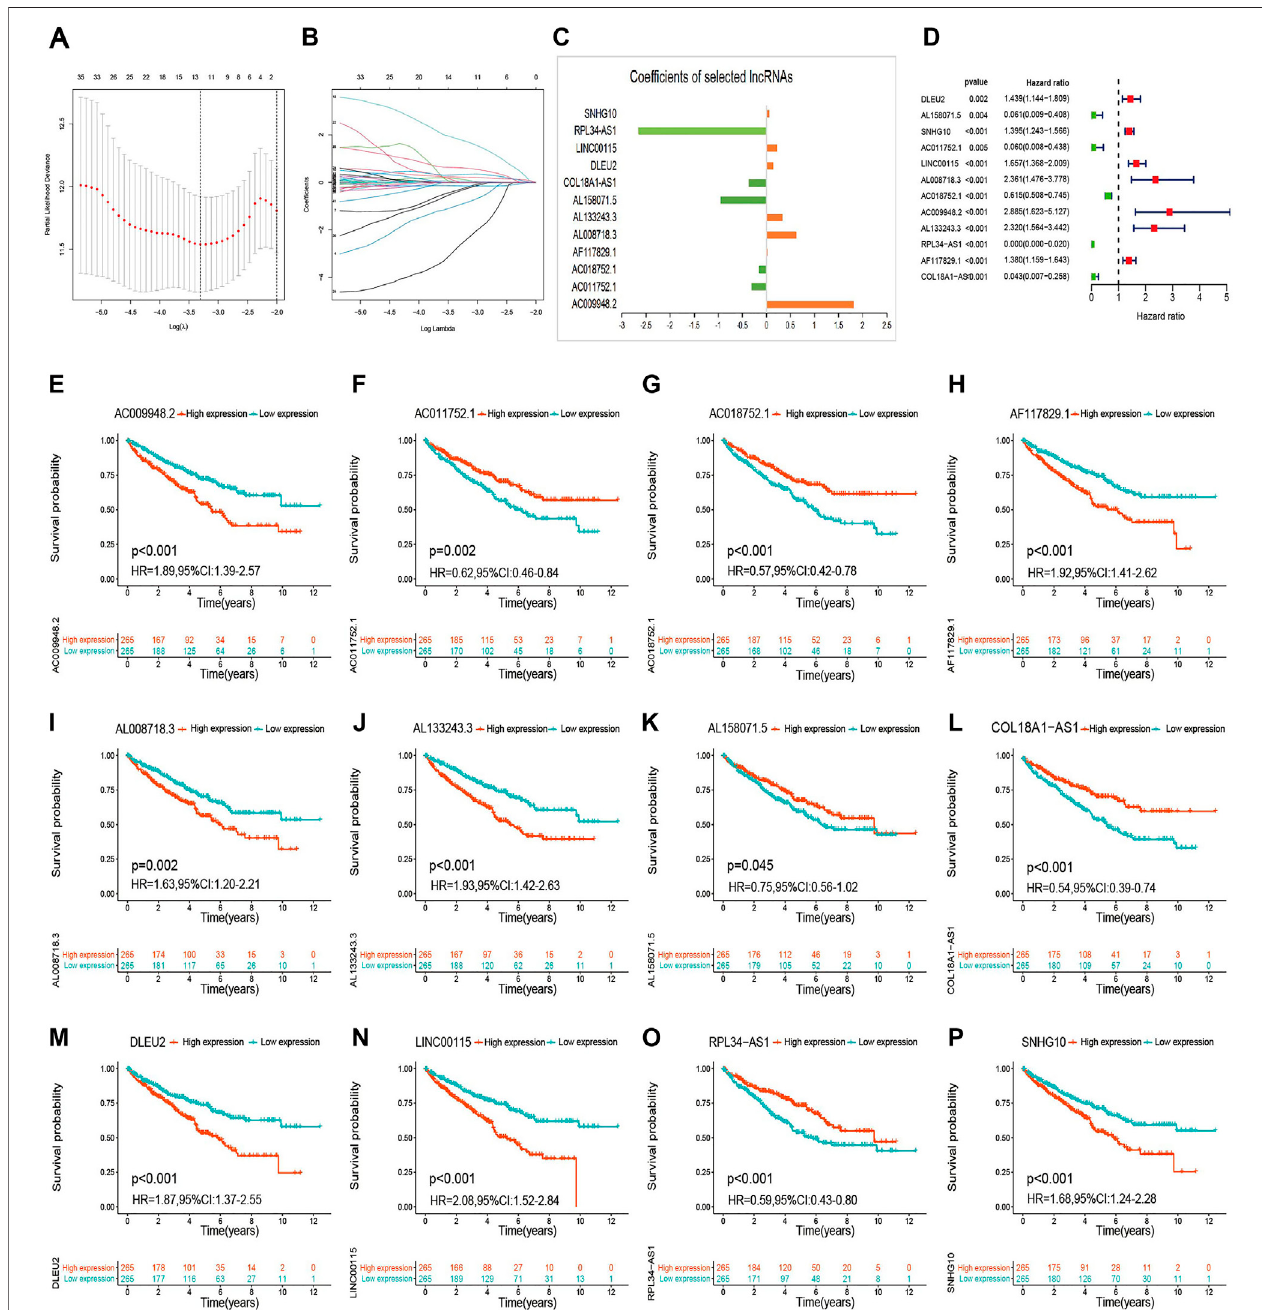
FIGURE5| Establishmentofthem6A-RLPS. (A – C) LASSOCoxregressionanalysistodeterminethe12m6A-RLsandtheircorrespondingcoef fi cients. (D) Forest plot of the 12 m6A-RLs. (E – P) Kaplan – Meier curves indicating different overall survival (OS) of patients with different expression levels of the 12 m6A-RLs.